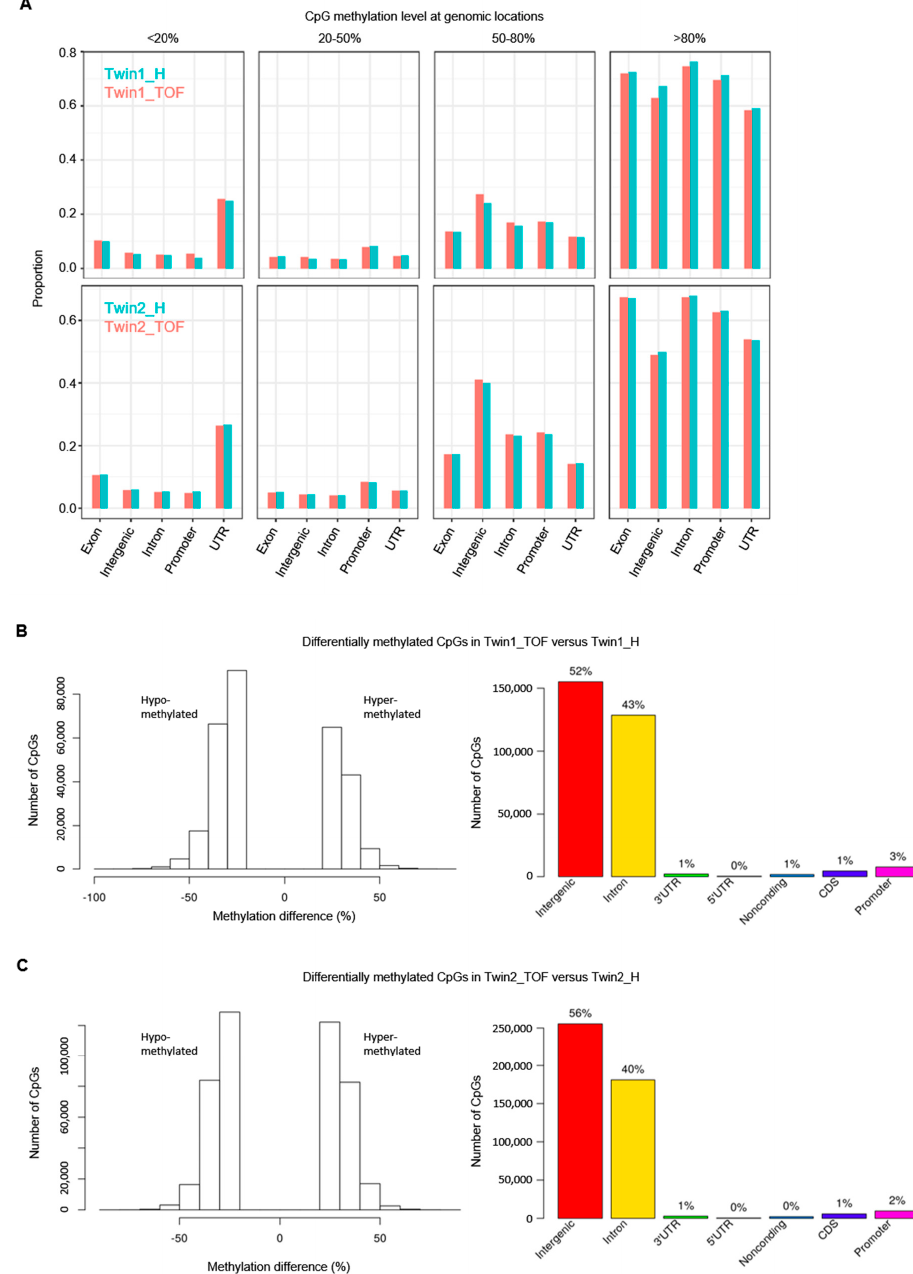
Figure 2. DNA methylation levels and di ff erences of CpG sites in twins and their genomic locations. ( A ) Overview of methylation levels of CpGs at genomic locations. Proportions of CpG are given over the total count for each feature (no pairwise comparison of single CpG sites). ( B ) Di ff erentially methylated (hypo- and hyper-methylated) CpG sites in Twin1_TOF compared to Twin1_H and their genomic locations. ( C ) Di ff erentially methylated (hypo- and hyper-methylated) CpG sites in Twin2_TOF compared to Twin2_H and their genomic locations. Di ff erentially methylated CpGs with at least 25% methylation di ff erence between a ff ected (*_TOF) and healthy (*_H)